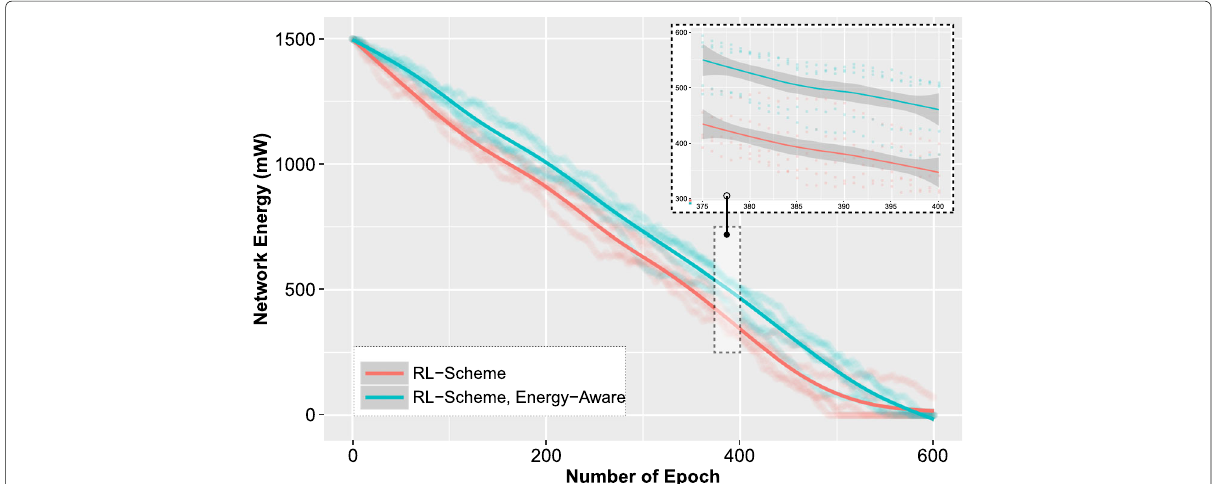
Fig. 7 Energy left in sensor network, for the RL scheme, and the RL energy-aware